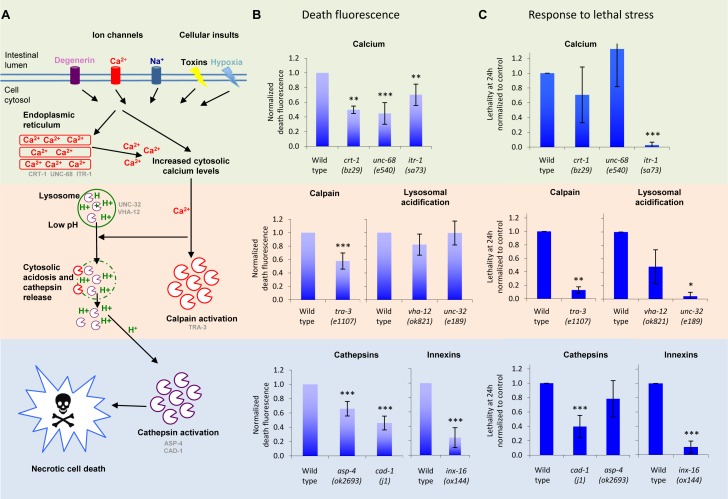
Inhibition of necrosis pathway reduces DF.(A) The calpain-cathepsin necrosis cascade. (B) Effects of inhibition of necrosis on DF, in ER calcium mutants, a calpain mutant, lysosomal acidosis mutants, cathepsin mutants, and an innexin mutant. Death was induced by freeze-thaw in young adults. Plots in (B) and (C) show mean ± SD, *p<0.05, **p<0.01 and ***p<0.001. Statistics: Wild type, N = 7 independent assays (different days), 50 worms/assay n = 350; asp-4, N = 7, n = 350, p<0.001; crt-1, N = 3, n = 150, p<0.01; unc-68, N = 6, n = 300, p<0.001; itr-1, N = 6, n = 300, p<0.01; tra-3, N = 6, n = 300, p<0.001; vha-12, N = 7, n = 350, p>0.05; unc-32, N = 6, n = 300, p>0.05; cad-1, N = 7, n = 350, p<0.001; inx-16, N = 6, n = 300, p<0.001. (C) Most necrosis mutants are significantly more resistant to death induced by osmotic stress (500 mM NaCl). Wild type, N = 6, n = 300; asp-4, N = 7, n = 350, p>0.05; crt-1, N = 5, n = 250, p>0.05; unc-68, N = 2, n = 150, p>0.05; itr-1, N = 3, n = 300, p<0.001; tra-3, N = 3, n = 100, p<0.01; vha-12, N = 3, n = 150, p>0.05; unc-32, N = 2, n = 100, p<0.05; cad-1, N = 6, n = 300, p<0.001; inx-16, N = 4, n = 200, p<0.001.